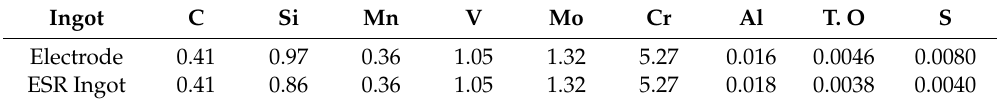
Table 1. Chemical compositions of the consumable electrode and the ESR ingot, mass%.